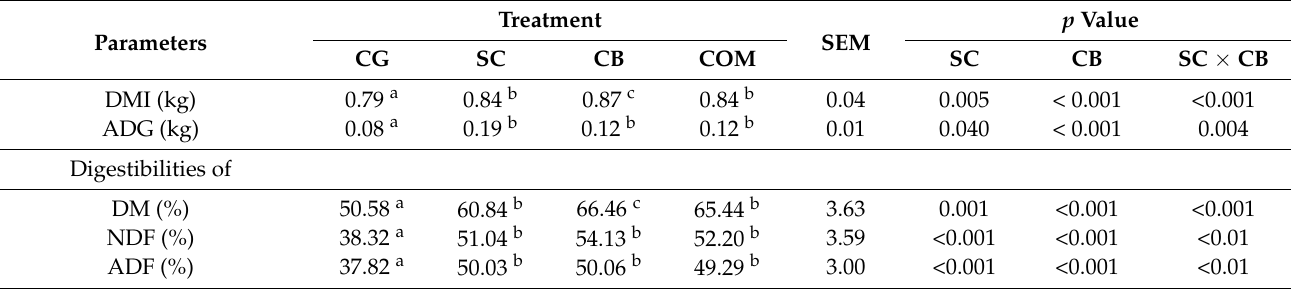
Table 4. The growth performance parameters of heat-stressed goats with probiotics supplementation.